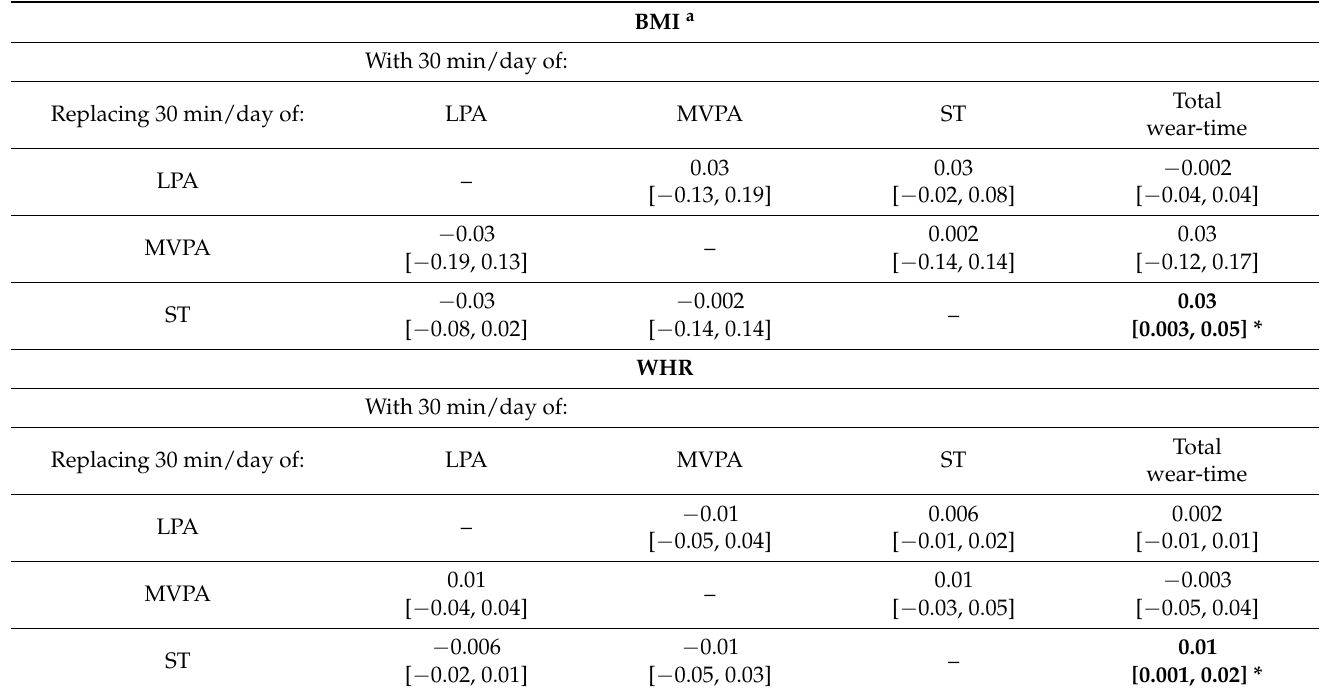
Table 5. Isotemporal substitution associations ( β [95% CI]) using 30 min reallocations between 30-month changes in non-school time LPA, MVPA, and ST and BMI, WHR, and BF% at 30-month follow-up in girls ( n = 71). BMI a With 30 min/day